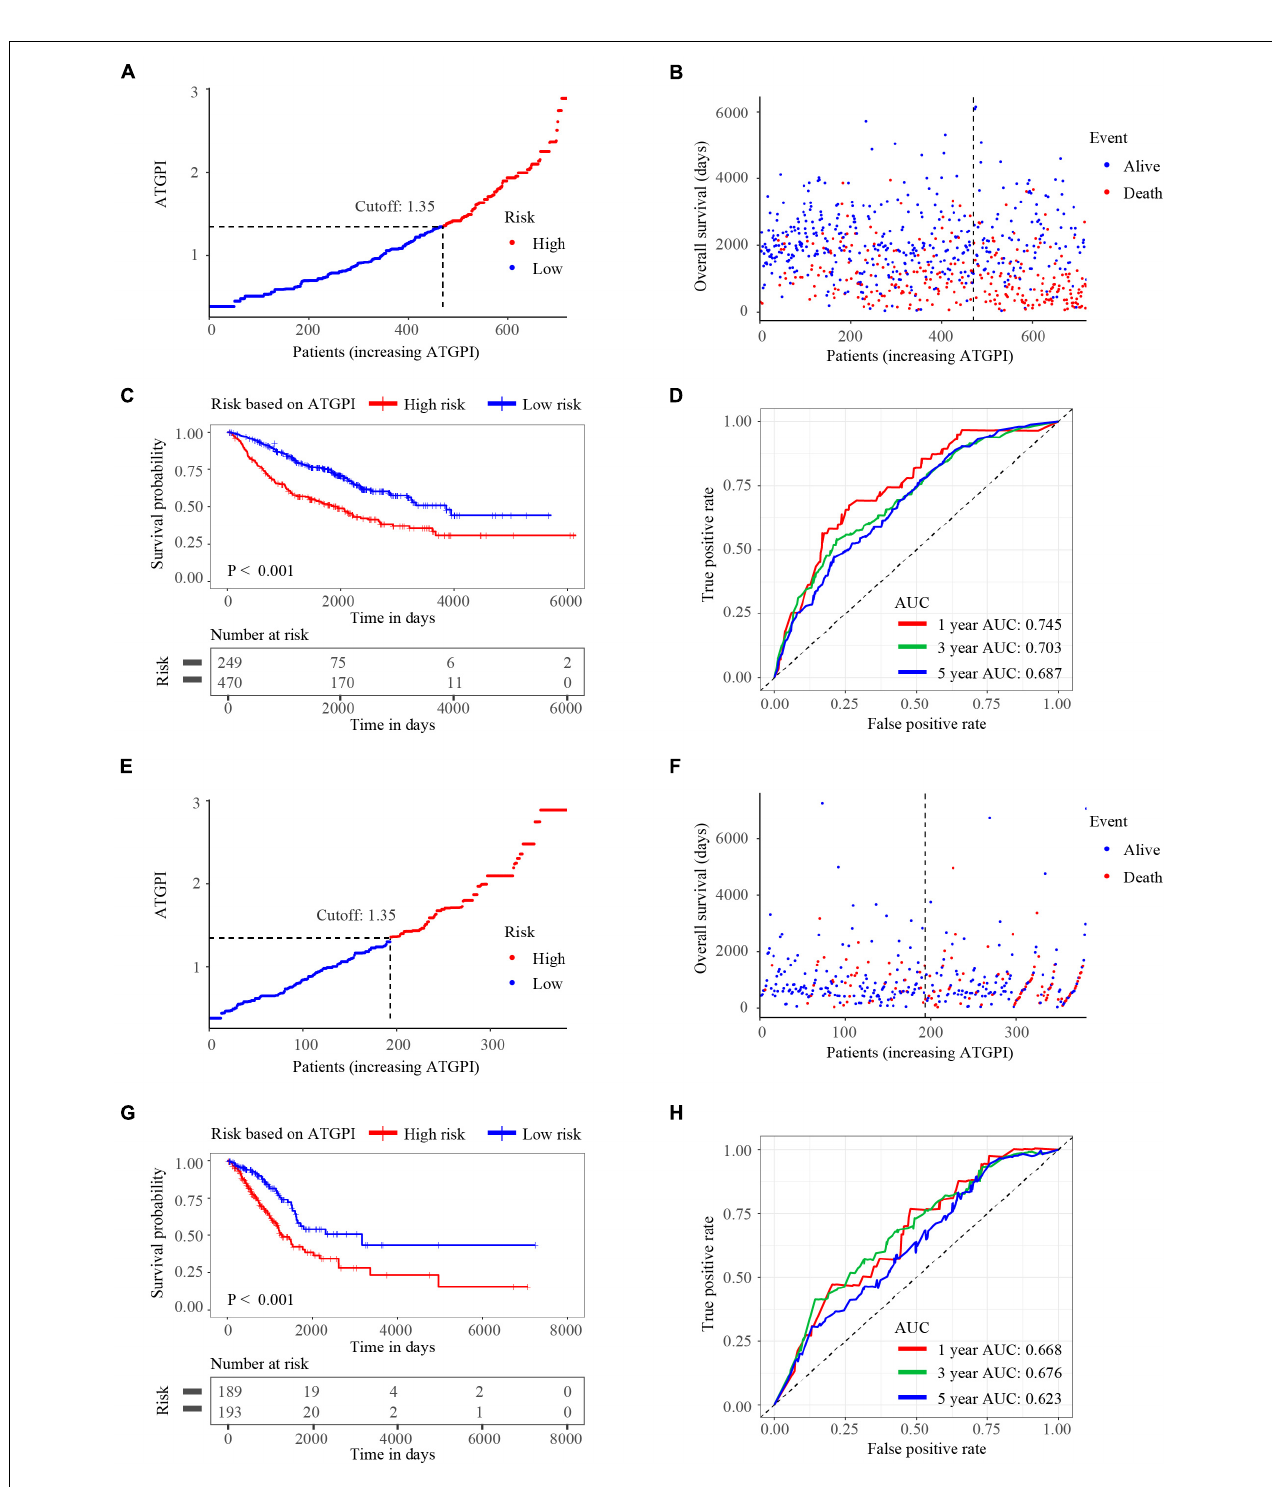
FIGURE 3 | The risk curves, Kaplan-Meier (KM) curves, and time-dependent receiver operator characteristic (ROC) curves of patients in the testing and The Cancer Genome Atlas (TCGA) validation cohorts based on the autophagy-related gene pair index (ATGPI). (A,B) Risk curves and scatterplots of vital status for patients in the testing cohort. (C) The KM curves of low and high ATGPI groups in the testing cohort. (D) The area under the curves (AUC) of time-dependent ROC curves in the testing cohort. (E,F) Risk curves and scatterplots of vital status for patients in the TCGA validation cohort. (G) The KM curves of low and high ATGPI groups in the TCGA validation cohort. (H) The AUC of time-dependent ROC curves in the TCGA validation cohort.